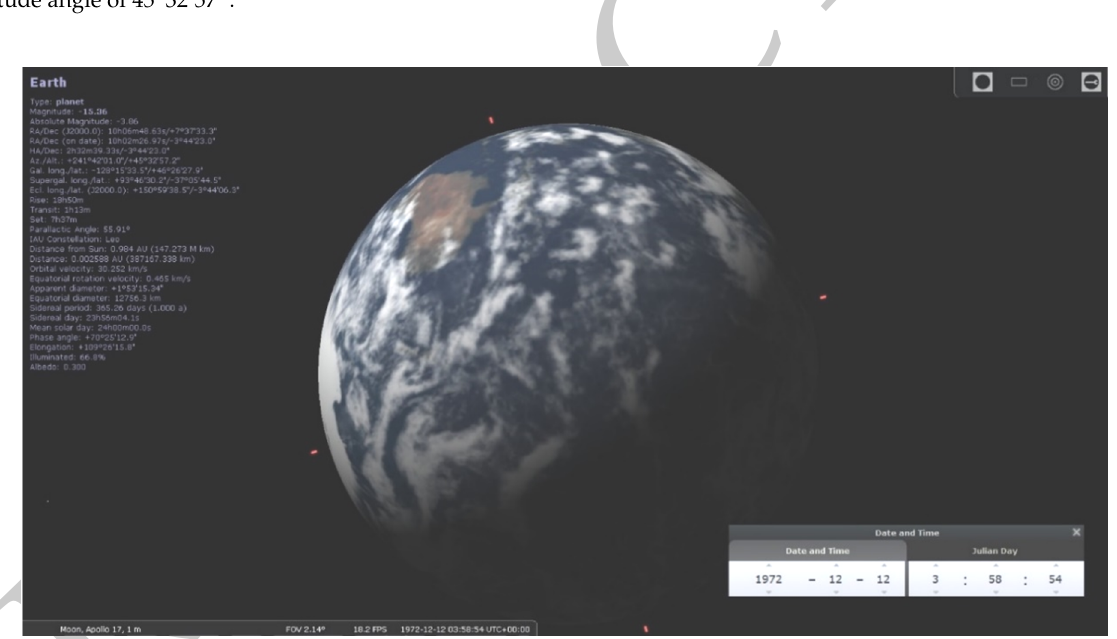
Figure 5. Detailed view of the Earth as shown from the landing site of Apollo 17. Australia and Antarctica could clearly be seen if the cloud formations permitted at the time.